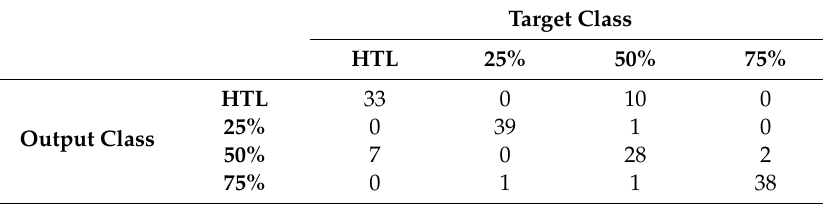
Table 5. Confusion matrix for the training of the ANN classifier with extraction of statistical features.